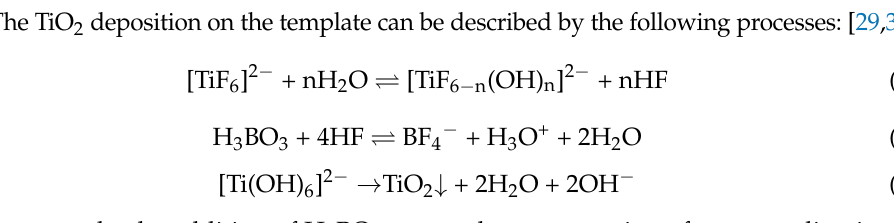
Figure 5. XRD of the different samples ( a ) before and ( b ) after annealing.